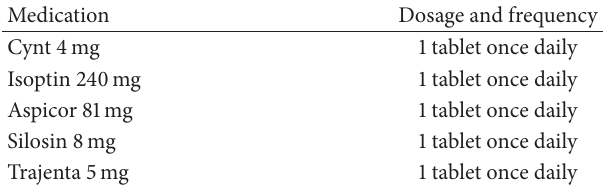
Figure 2: Bladder neck Botox injections at 3 o’clock.